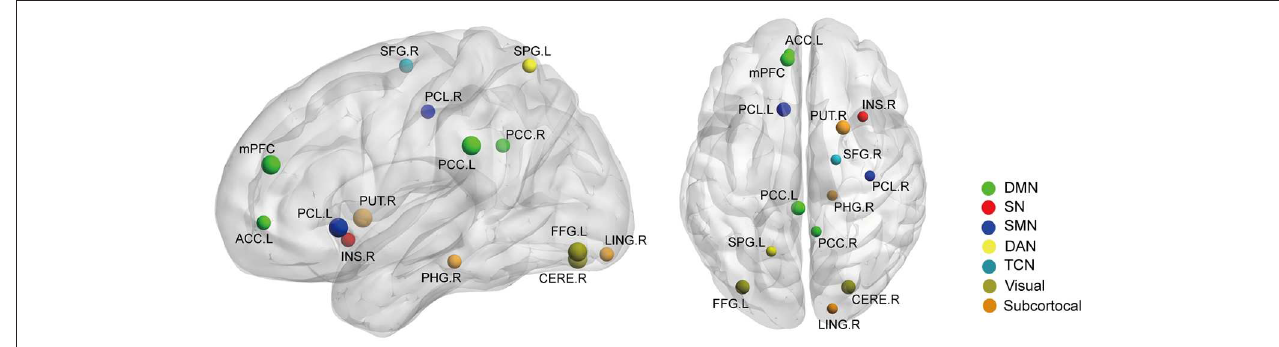
FIGURE 6 | The gray matter volume (GMV) differences between the AS patients and HCs ( p < 0.05, FDR corrected). Ball color indicates different brain networks. Ball size indicates the difference direction (bigger ones: AS > HC; smaller ones: AS < HC). DMN, default mode network; SN, salience network; SMN, sensory/somatomotor network; DAN, dorsal attention network; TCN, fronto-parietal task control network.